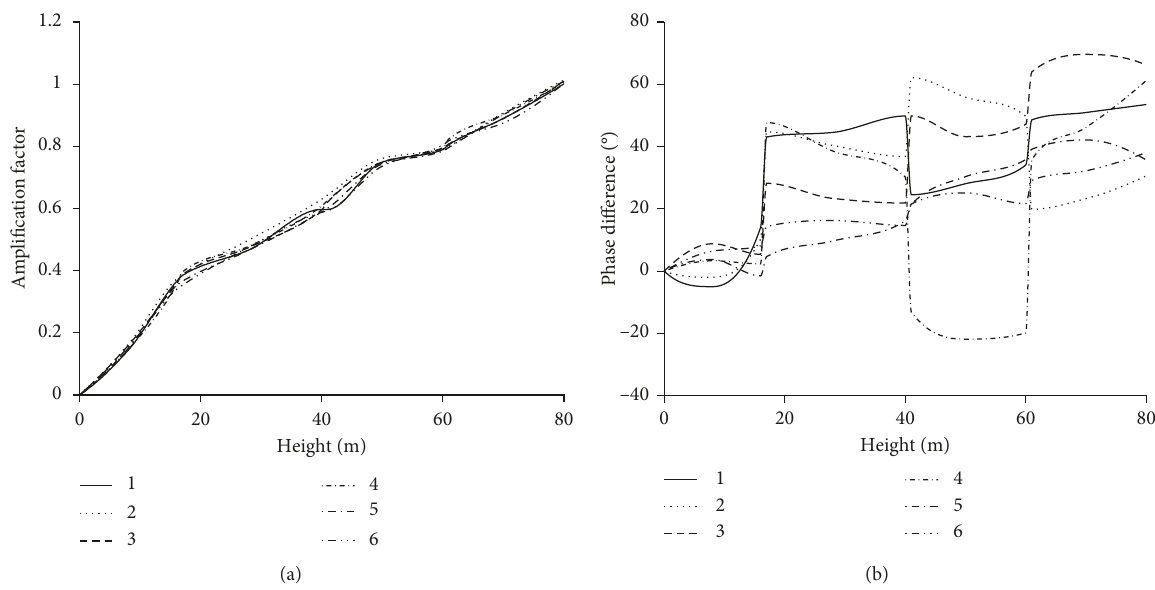
Figure 8: Vibration modes and phase differences of the No. 5 wind turbine tower. (a) The first-order vibration mode under six working conditions. (b) The first-order phase difference under six working conditions.